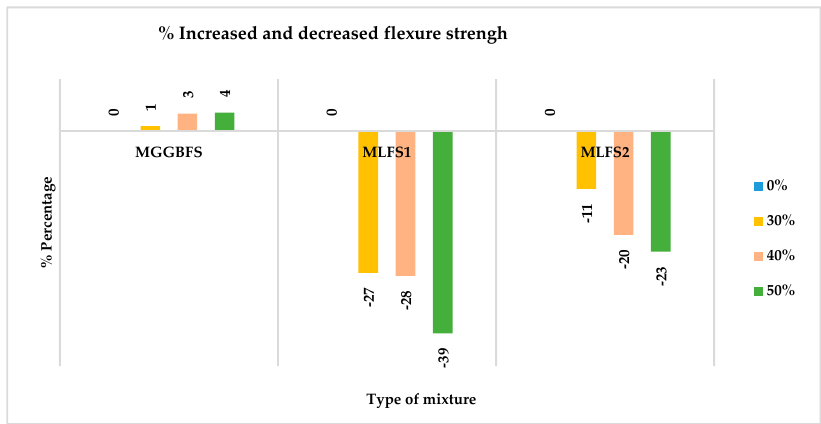
Figure 12. Percentage increased and decreased flexure strength.